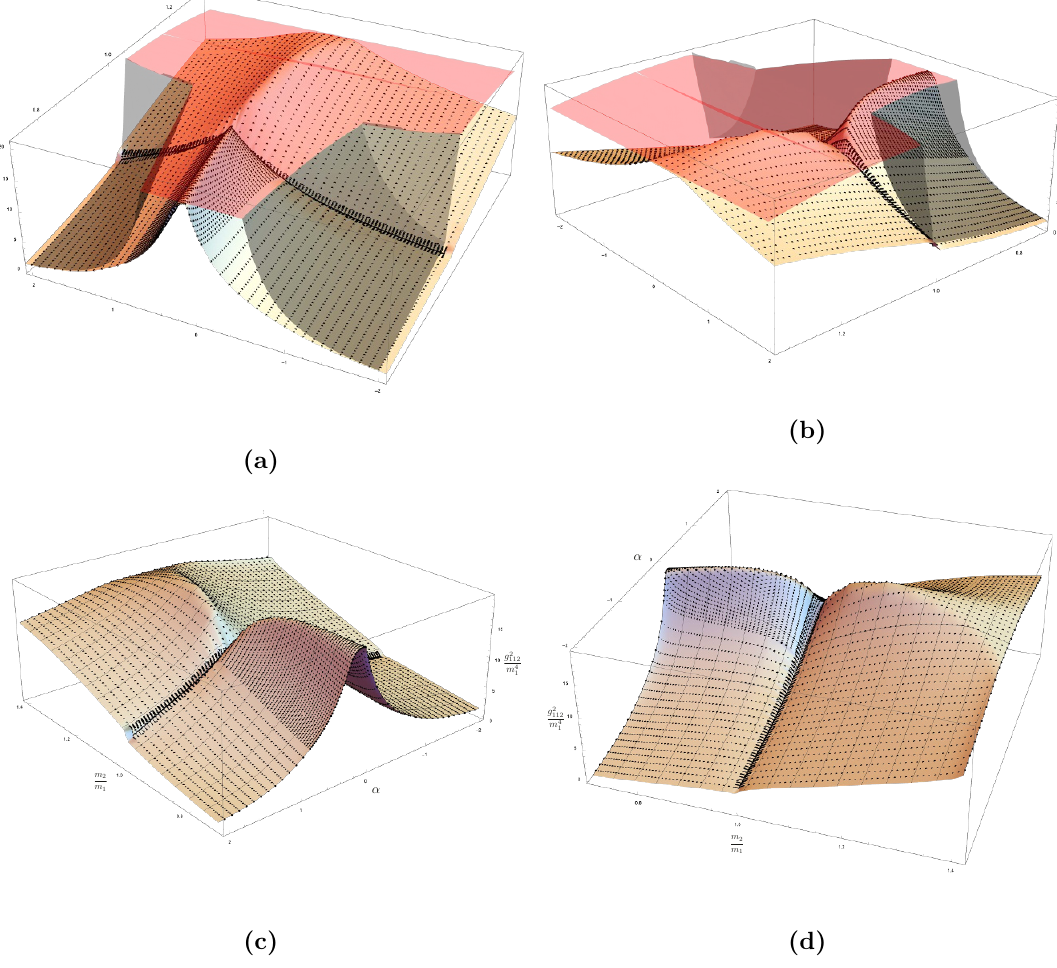
Figure 16. Bounds on g 2 following from the multiple amplitudes analysis, as a function of (cid:11) and 112 m 2 =m 1 . These bounds should hold for any Z 2 symmetric quantum (cid:12)eld theory with two particles in the spectrum, 1 being odd and 2 being even. They improve the bounds derived from individual amplitudes, corresponding to the red and black surfaces. As can be seen from the various angles (a)-(d), the bound surface has many interesting features that are described in the main text.